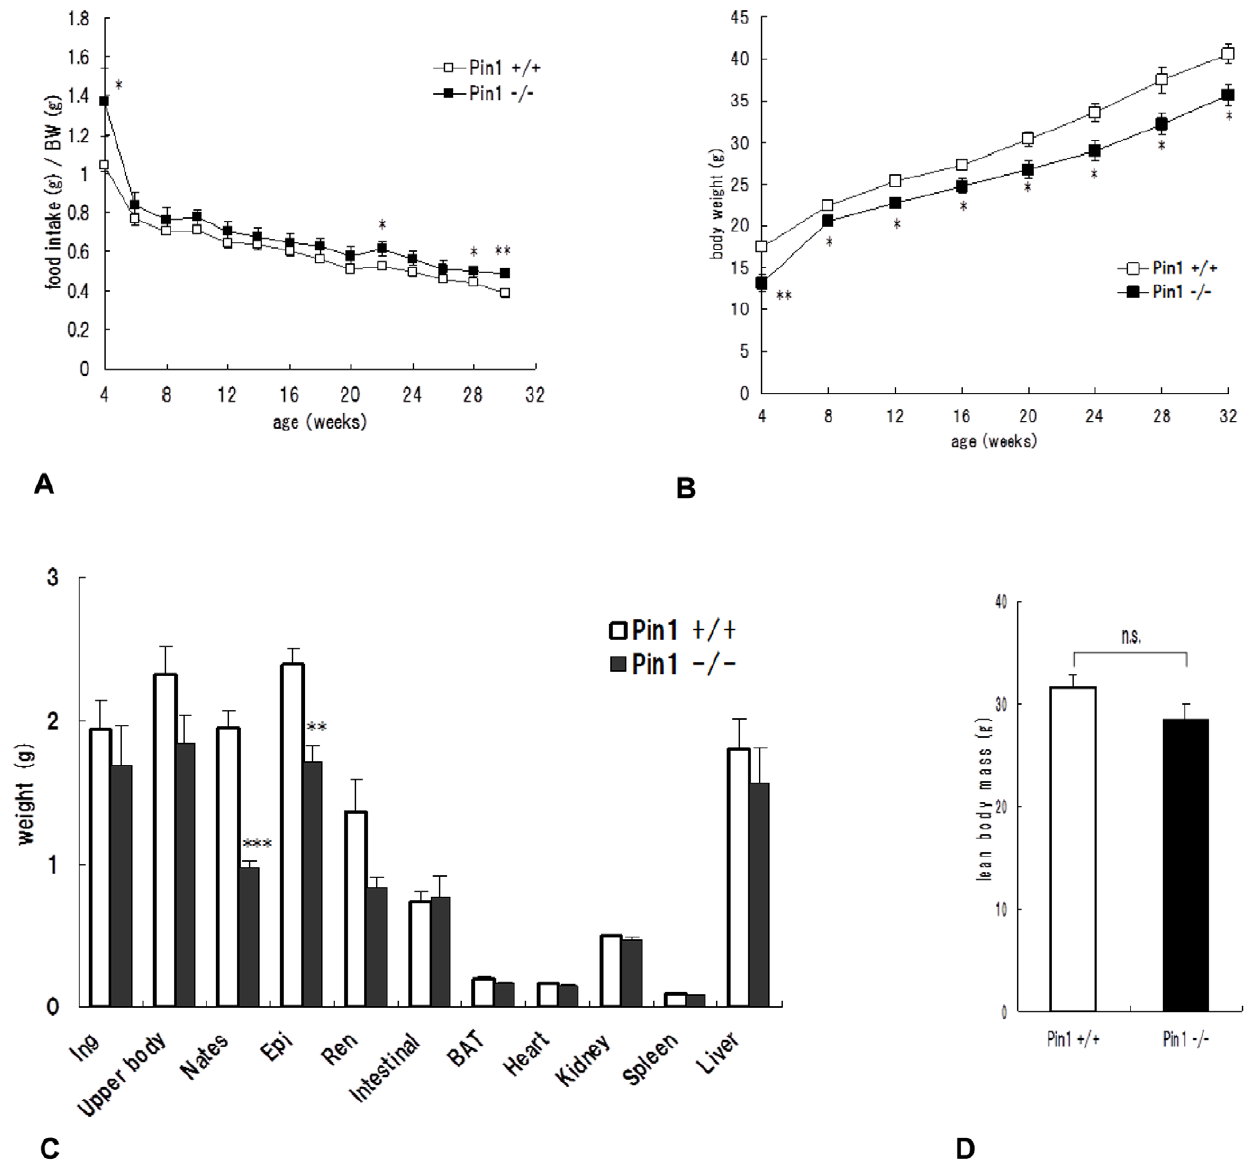
Figure 2. Relationship between quantity of fat and Pin1 expression. High fat diets were fed to wild-type (n=8) and Pin1 2 / 2 (n=5) mice between the ages of 4–28 weeks and the amount of food intake (A) and body weight (B) were recorded. Weights of subcutaneous and genital fat tissues were measured (C). The total weight of all fat tissues removed was also measured (D). The amount of food intake per mouse weight was monitored. Student t-test *p , 0.05, **p , 0.01, ***p , 0.001. by insulin treatment and the fat droplets stained with Oil Red O droplets were stained red by Oil Red O solution and the rate of were observed under a microscope. The wild-type MEFs differentiation was determined semi-quantitatively. siRNA against differentiated into adipose cells that can be clearly observed after Pin1 [4,10] decreased the Pin1 level in NIH 3T3-L1 cells in 6 days (Fig. 4C-a). 8 days later, differentiation of the cells had progressed further with the number of cells staining red increasing (Fig. 4C-b). Pin1 2 / 2 MEFs did not differentiate as much as did wild-type MEFs after 6 days of insulin treatment (Fig. 4C-c), and even after 8 days, the number of stained cells was much less (Fig. 4C-d). Wild-type MEFs, Pin1 2 / 2 MEFs-treated with lenti- Pin1 (Lentiviral vector expressing Pin1), and mock-transfected (Lentiviral vector without insert) Pin1 2 / 2 MEFs were stimulated with insulin for 8 days, after which the rate of differentiation of MEFs was determined by measuring the absorbance of red color